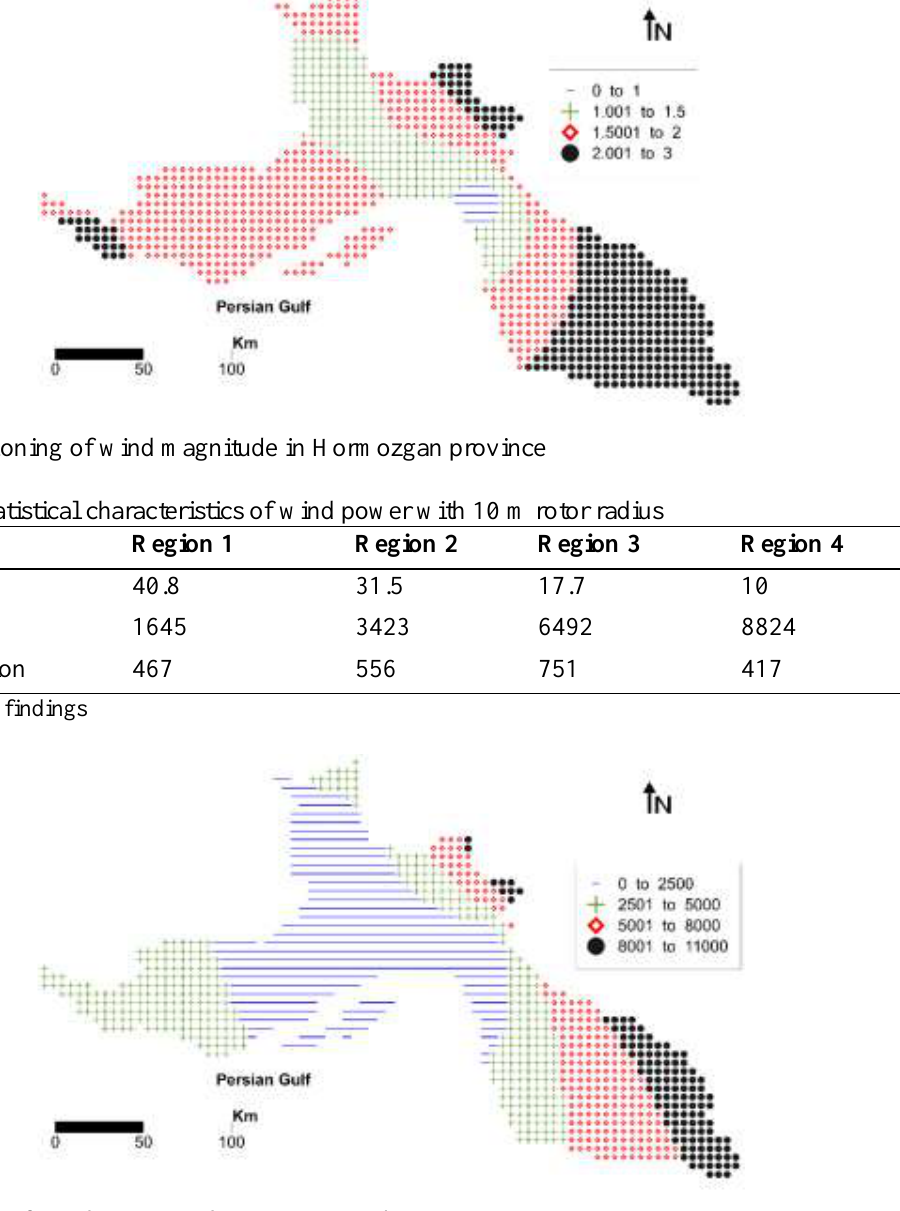
Figure 3 . Zoning of wind power with 10 m rotor radius The zoning of wind power with 15 m. rotor radius is shown in Figure 4. As in previous classifications, the eastern province has highest wind power of up to 24610 𝑤. 𝑚 −2 . Table 4